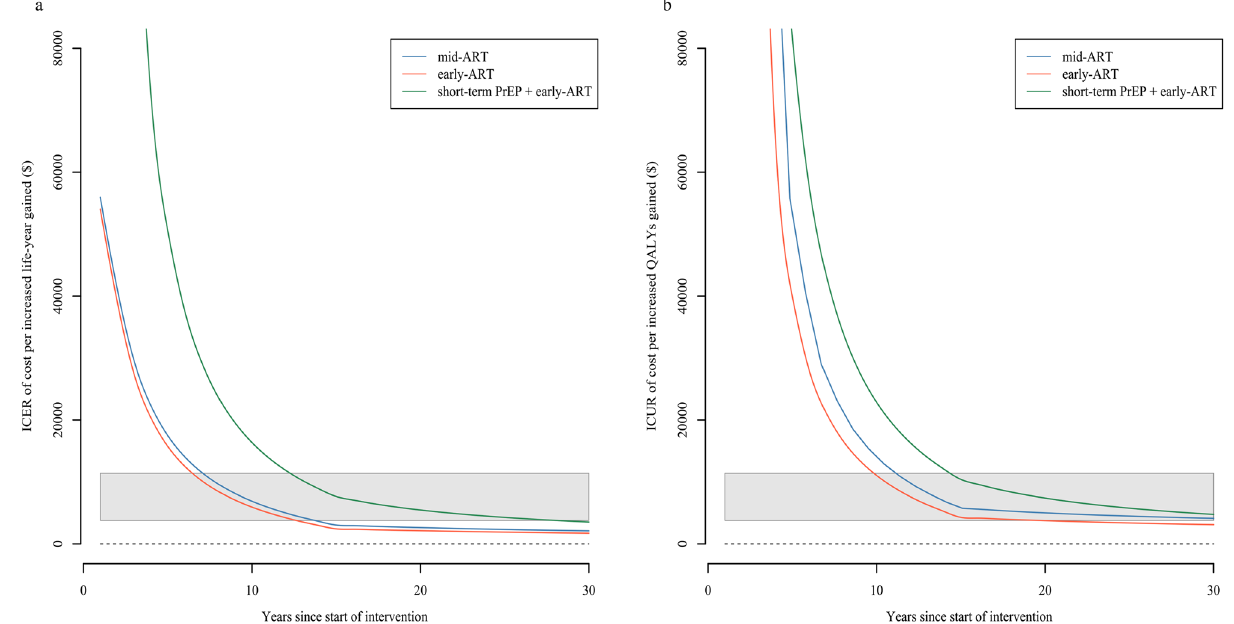
Figure 3. Outcomes of the intervention strategies at different time horizons. We calculated the incremental cost-effectiveness ratio (ICER) and incremental cost-utility ratio (ICUR) of targeted strategies compared with baseline strategies at 0–30 year’s horizon. ( a ) ICER of cost per life-year gained as a result of the model, for the three targeted strategies versus late-ART within HIV-serodiscordant couples. ( b ) ICUR of cost per QALY gained as a result of the model, for the three explored scenarios versus late-ART within HIV-serodiscordant couples. The grey band represents the $3797–11,391 threshold of cost-effectiveness of interventions and the black dotted line represents the cost-saving threshold (=